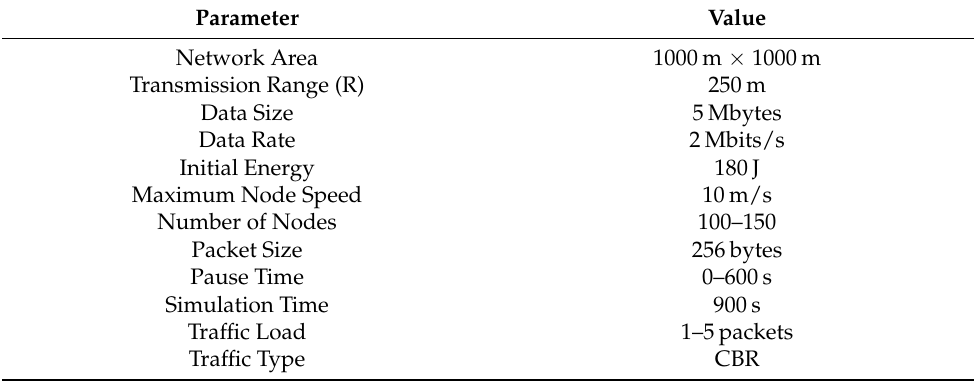
Table 2. Simulation